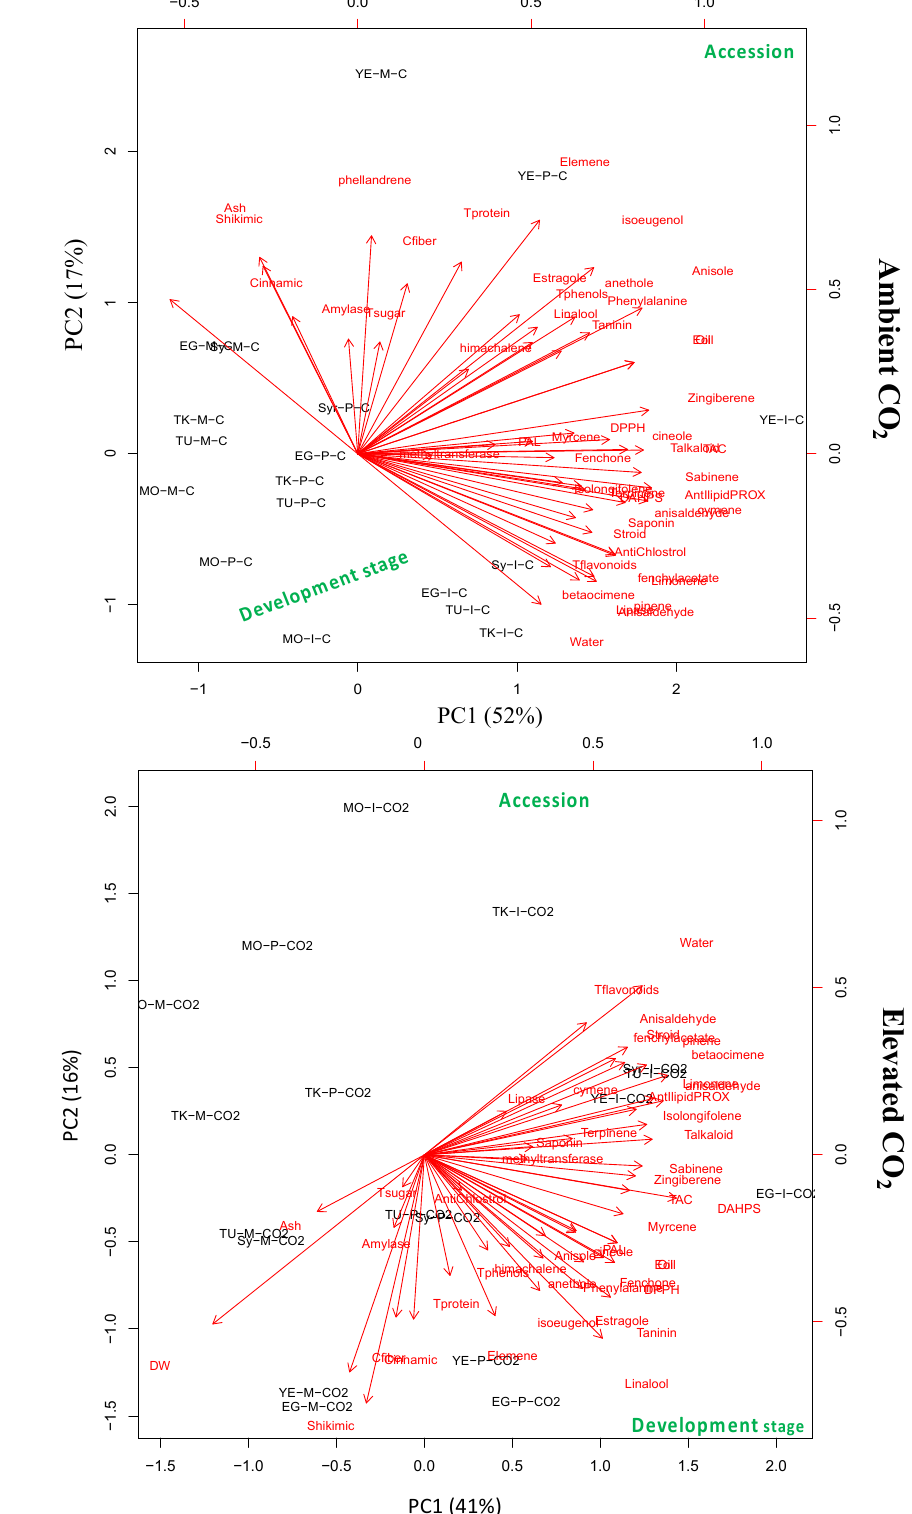
Figure 3. Principal component analysis (PCA) of seed chemical compositions and biological activities of six Pimpinella anisum L. accessions at three developmental stages under ( A ) ambient CO 2 (control) or ( B ) elevated CO 2 growth conditions.